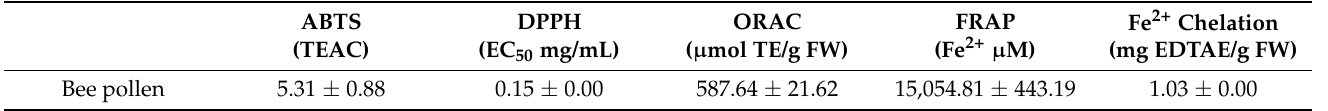
Table 4. ABTS, DPPH, ORAC, FRAP, and Fe2+ chelating ability results of bee pollen sample. Results were reported as mean values ± SD of three